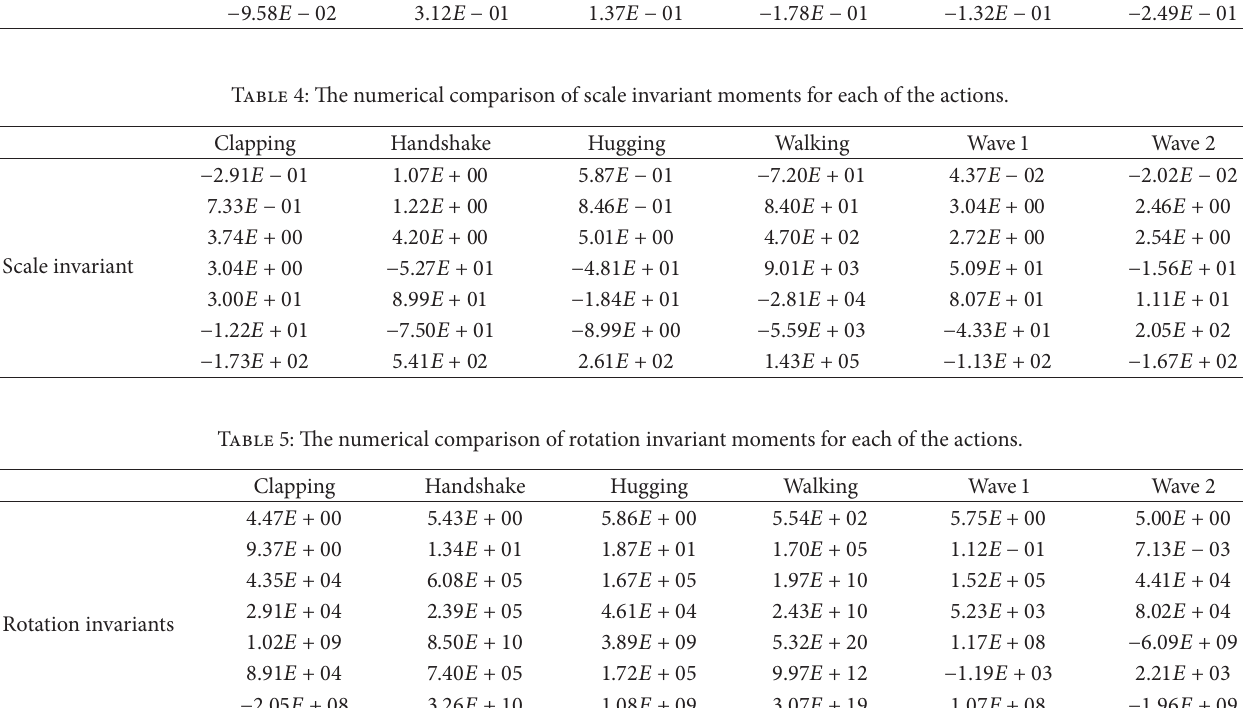
Table 3: The numerical comparison of image orientation for each of the actions. Clapping Handshake Hugging Walking Wave 1 Wave 2 Image orientation